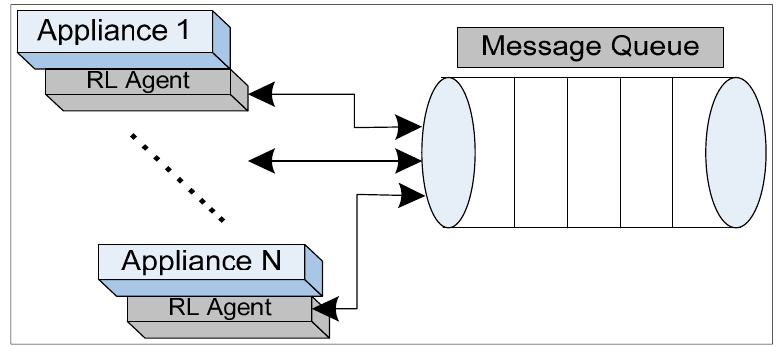
Figure 5. Message passing among appliances’ agents.